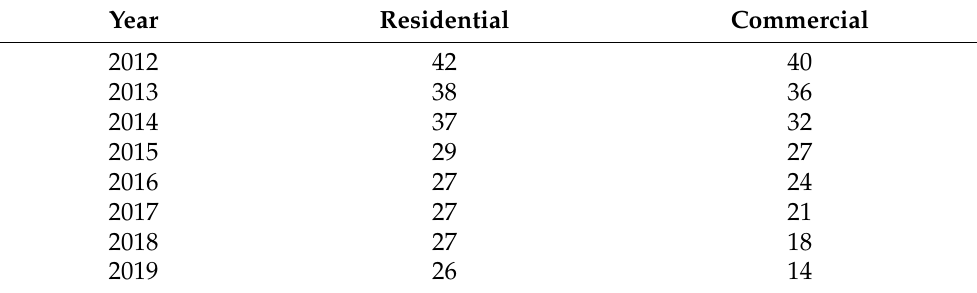
Table 3. FiT subsidy pricing for private and commercial installations (JPY/kWh) [42]. Year